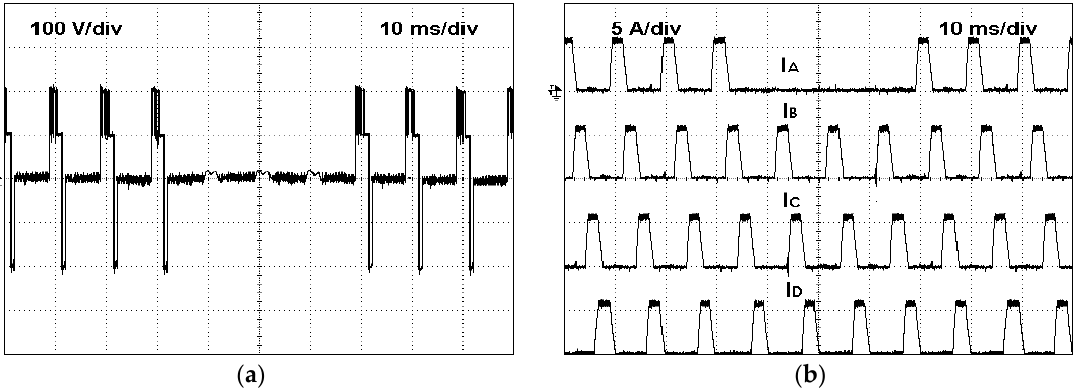
Figure 20. Experimental test with the converter operating in normal mode, then with an open-switch fault in the semiconductor S 21 ( a ) winding voltage of phase A and then in fault-tolerant mode ( b ) winding currents.